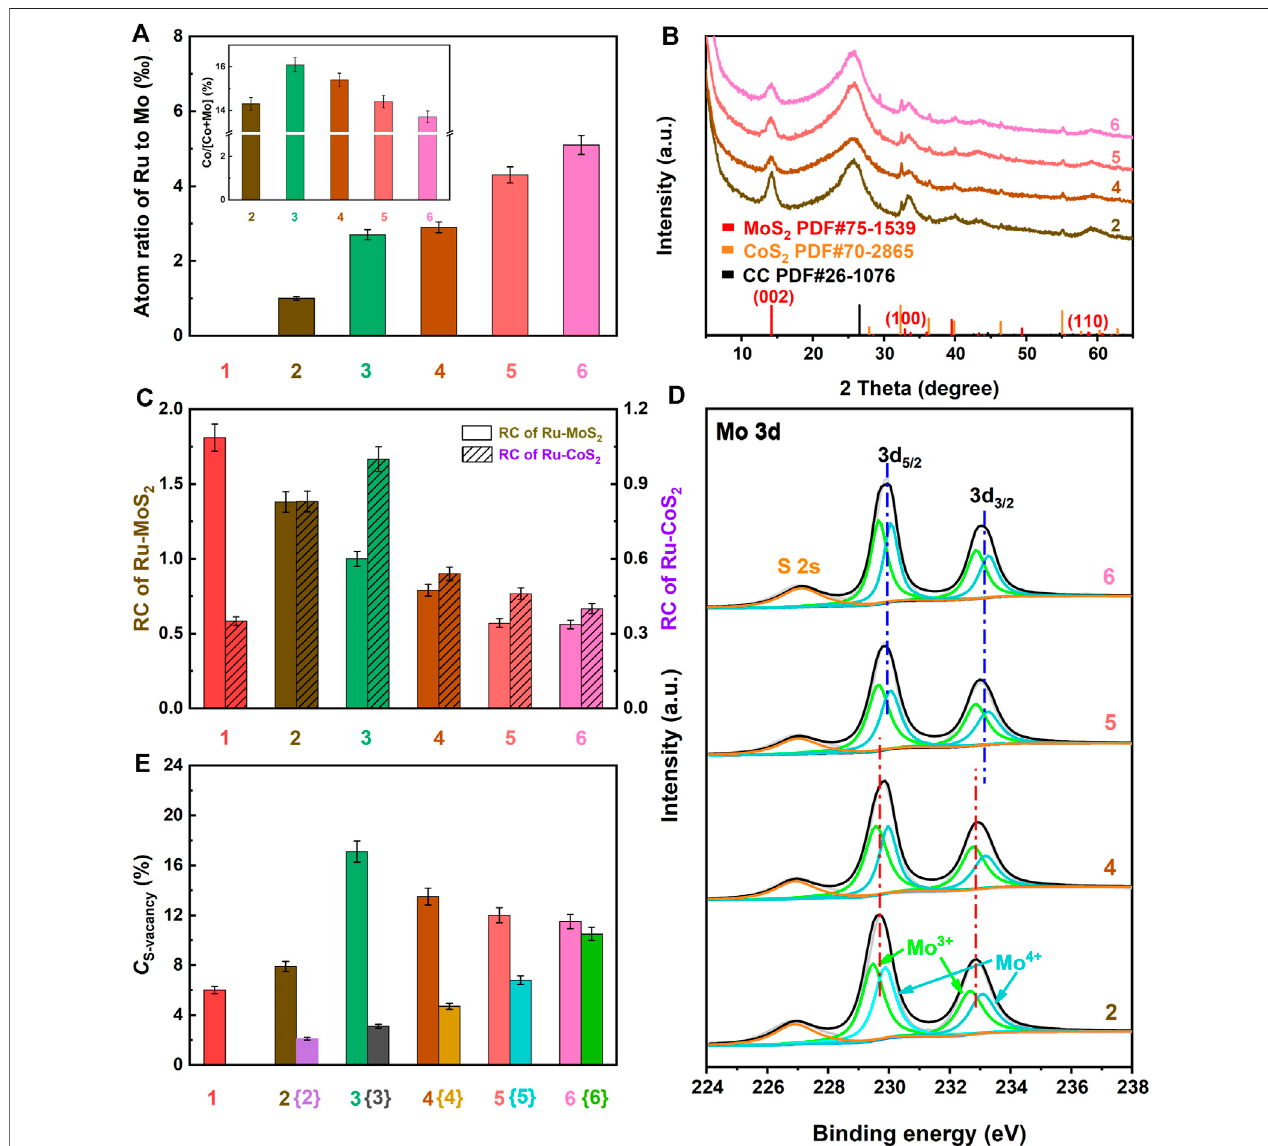
FIGURE 3 | (A) Atom ratio of Ru to Mo based on ICP-OES, (B) XRD patterns, (C) RC of Ru-MoS 2-x and Ru-CoS 2 , (D) Mo3d high-resolution XPS spectra, and (E) C S-vacancy of the related samples. Meanwhile, 1, 2, 3, 4, 5 and 6 are denoted as MoS 2 -CoS 2 /CC, Ru-MoS 2-x -CoS 2 /CC-1.0, the typical samples, Ru-MoS 2-x -CoS 2 /CC- 7.0, Ru-MoS 2-x -CoS 2 /CC-10.0, and Ru-MoS 2-x -CoS 2 /CC-30.0, respectively. Fabrications of {2}, {3}, {4}, {5}, and {6} are the same as those of Ru-MoS 2-x -CoS 2 /CC- 1.0,thetypicalsamples,Ru-MoS 2-x -CoS 2 /CC-7.0,Ru-MoS 2-x -CoS 2 /CC-10.0,andRu-MoS 2-x -CoS 2 /CC-30.0exceptfortheabsenceofCo(NO 3 ) 2 ,tobedenoted as Ru-MoS 2 /CC-1.0, Ru-MoS 2 /CC, Ru-MoS 2 /CC-7.0, Ru-MoS 2 /CC-10.0, and Ru-MoS 2 /CC-30.0, respectively. The inset of panel (A) is the atom ratio of Co to (Co + Mo) of the related samples based on